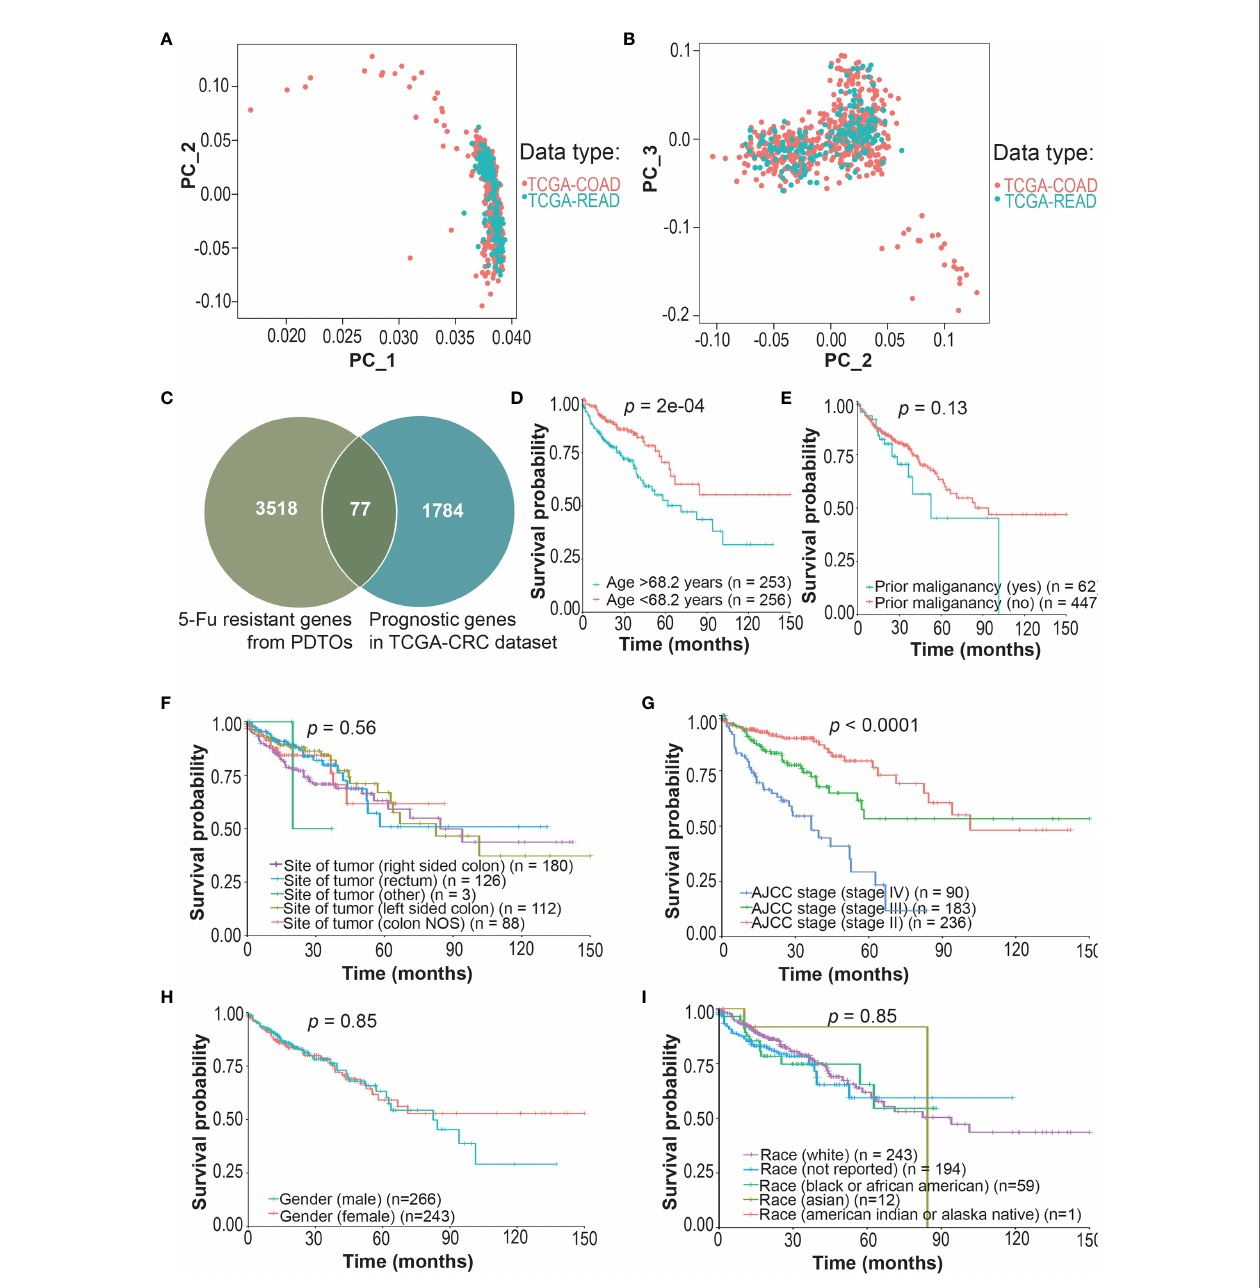
FIGURE 4 | Screening of drug (5-Fu)-resistant genes (DRGs) associated with prognosis in colorectal cancer patients (CRCpts). (A, B) PCA for the gene expression data of TCGA-COAD and TCGA-READ cohorts. (C) Venn diagram of 5-Fu-resistant genes from patient-derived tumor organoids (PDTOs) and prognostic genes in TCGA-CRC dataset. (D – I) Univariate analysis for age/prior maliganancy/site of tumor/AJCC stage/gender/race and their correlation with clinical outcome [overall survival (OS)] in TCGA-CRC cohort. PC, principal components; TCGA, the cancer genome atlas; COAD, colon adenocarcinoma; READ, rectal adenocarcinoma; 5-Fu, 5- fl uorouracil; PDTOs, patient-derived tumor organoids; CRC, colorectal cancer; NOS, not otherwise speci fi ed; AJCC, American Joint Committee on Cancer; DRGs, drug-resistant genes; CRCpts, colorectal cancer patients; PCA, principal components analysis; OS, overall